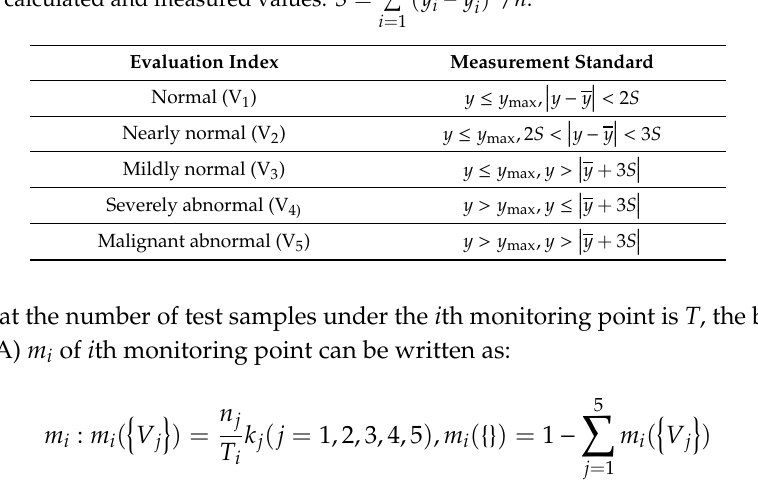
Table 1. The evaluation index for single monitoring point. Where y is the measured value of testing samples, y is the predicted value of testing samples, S are the mean square deviations of the di ff erence between the calculated and measured values: S =